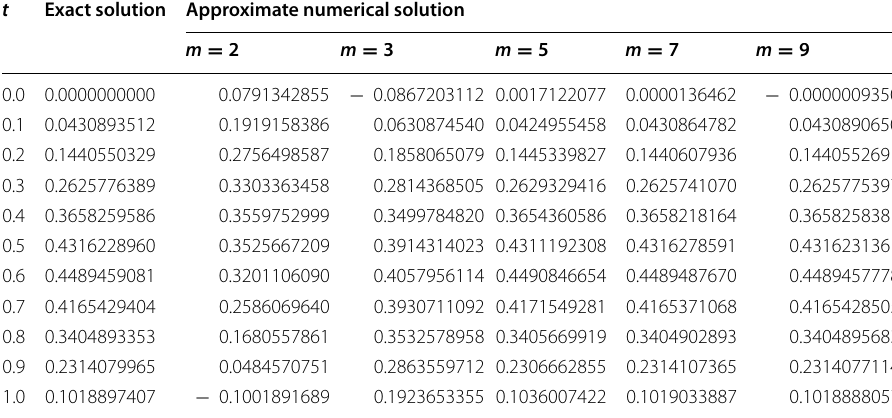
Table 1 Numerical results of solutions y ( t ) corresponding to Example 1